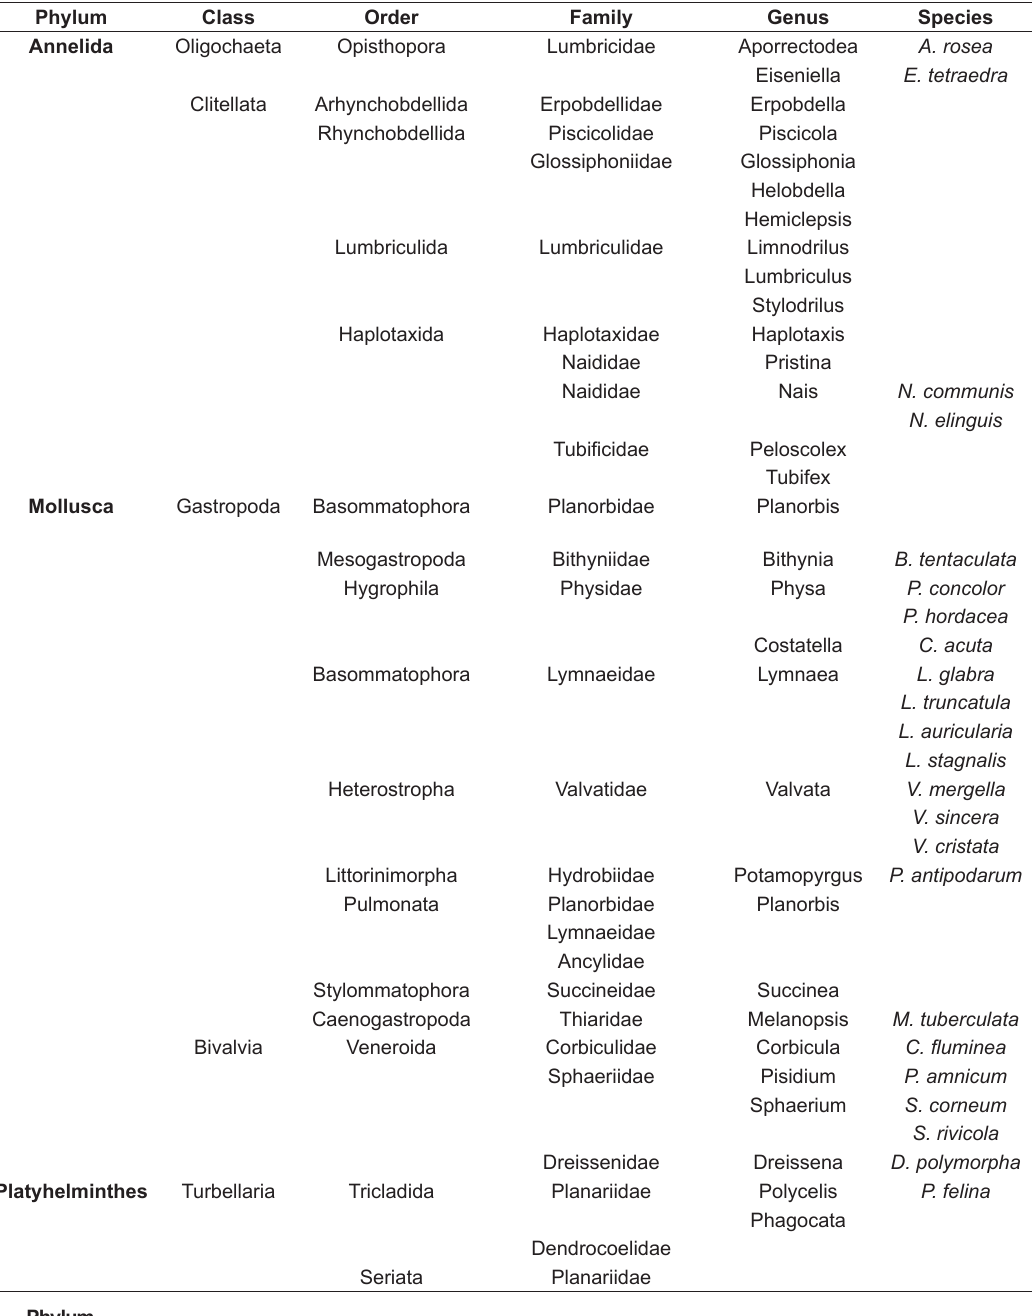
Table 1. List of suggested identification for macroinvertebrates found in the Iranian running waters, being updated based on the Animal Diversity Web (ADW) and appropriate literature